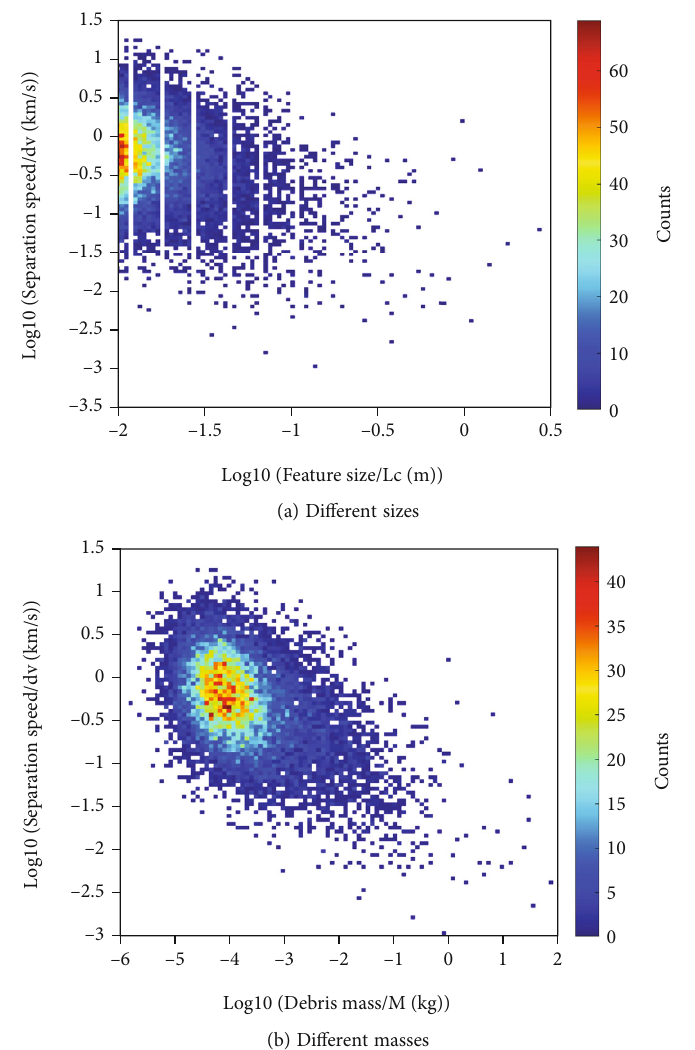
Figure 14: Impact debris separation rate-characteristic size distribution and impact debris separation rate-debris mass